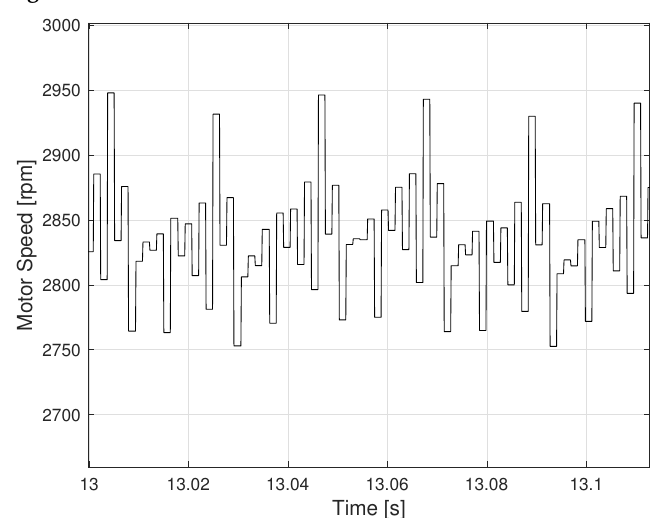
Figure 8. Magnification of motor speed time